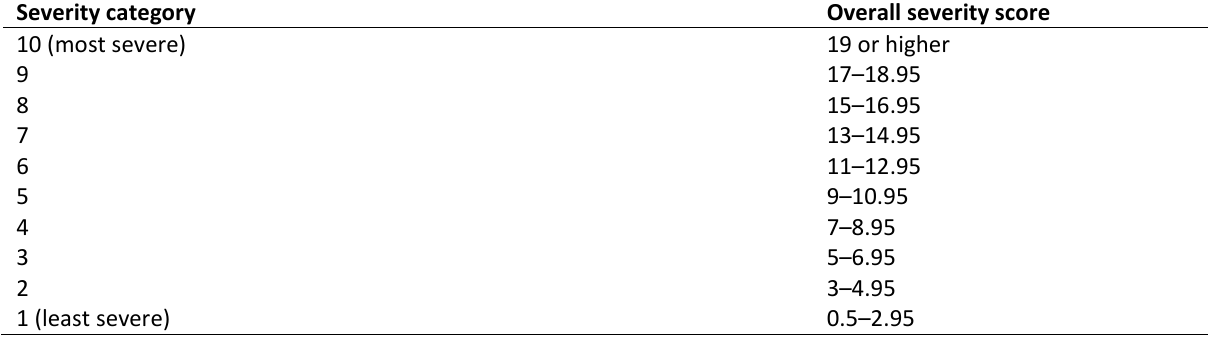
Table 1. Levels of disability severity in accordance with overall severity scores Sources: Grundy et al. (1999) and Martin et al.